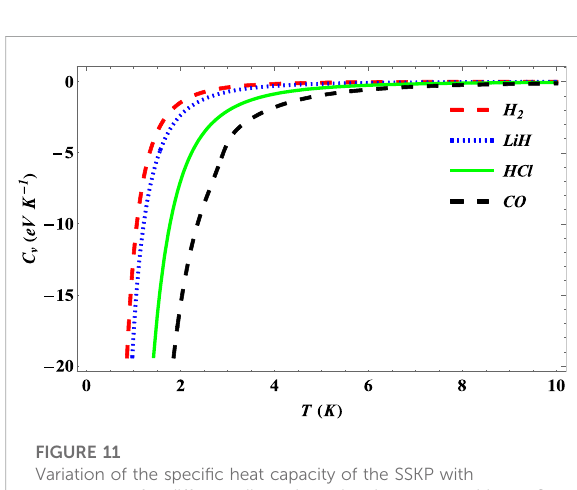
FIGURE 7 Variation of the partition function of the SSKP with temperature for different diatomic molecule systems with n = 2 and l = 1.